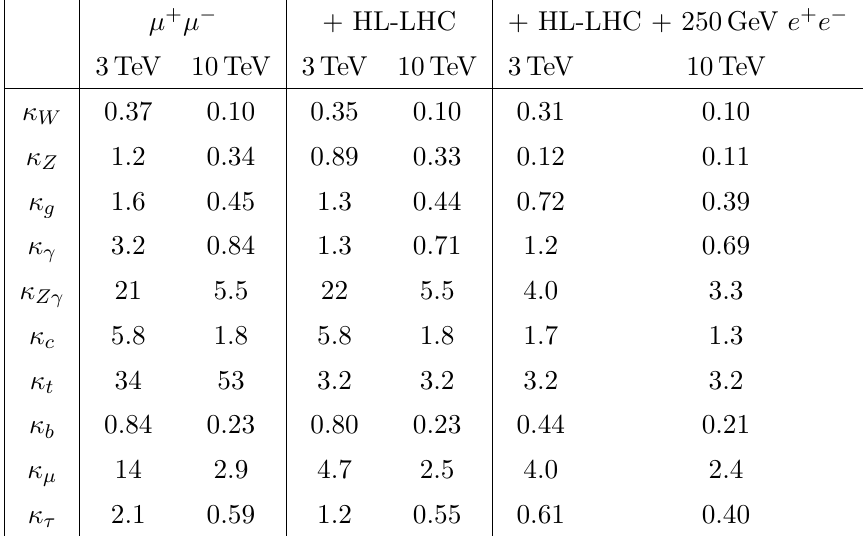
Table 12 . Results of a 10-parameter fit to the Higgs couplings in the κ -framework, based on the attainable precision in each production and decay channel with forward muon tagging up to | η | < 6 listed in table